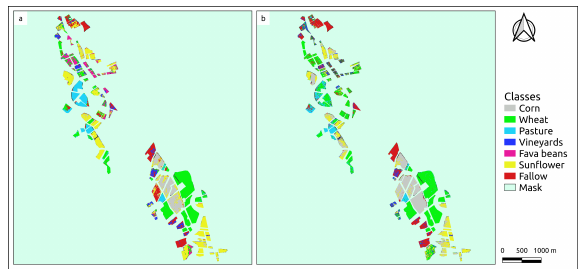
Figure 5. Classified Images in Scenario 2. a) RF for the date 2019-03-20 with bands and indices. b) SVM for the date 2019-03-20 with bands (Scenario